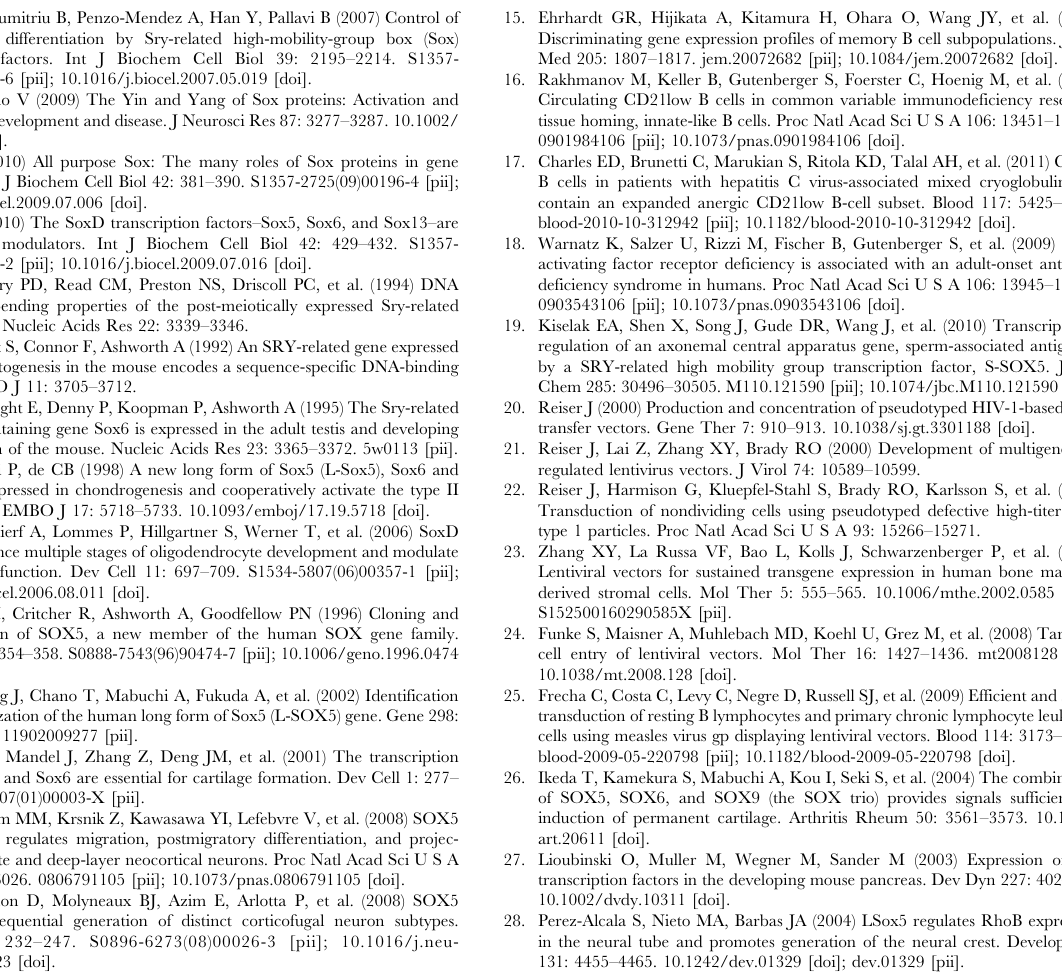
Table S1 Primer sequences used in this study.